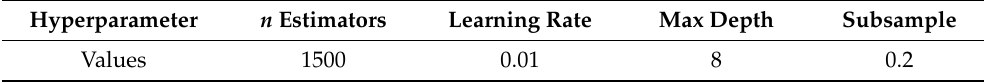
Table 2. Hyperparameters for the GBRT model.